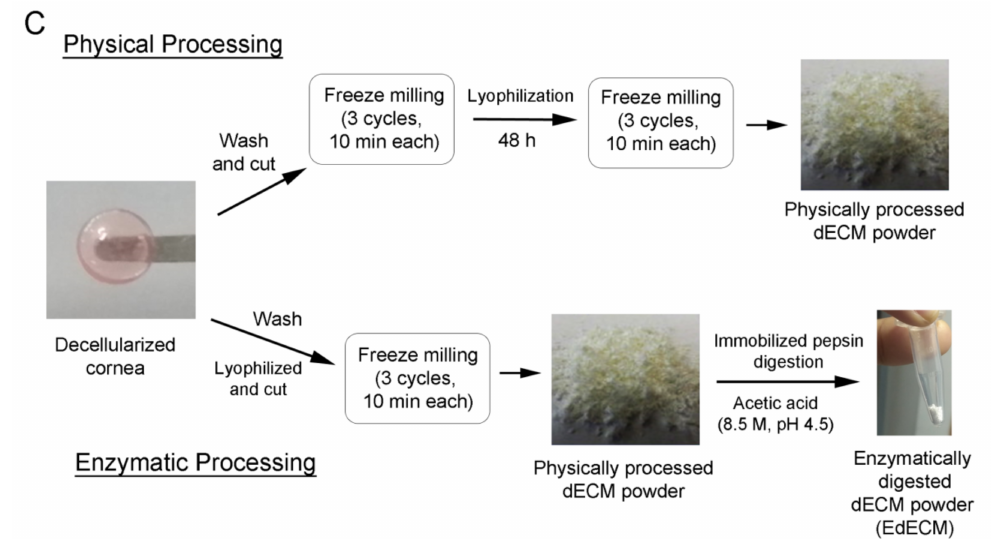
Figure 1. Schematic representation depicting the preparation of physically milled and enzymatically digested human cadaveric cornea derived decellularized ECM microparticles. ( A ) Decellularization process of cadaveric human donor corneas unfit for clinical transplantation; ( B ) nuclei (DAPI) and H&E stain demonstrating the absence of genetic material; and ( C ) preparation of physically processed and pepsin enzyme digested dECM microparticles from decellularized human